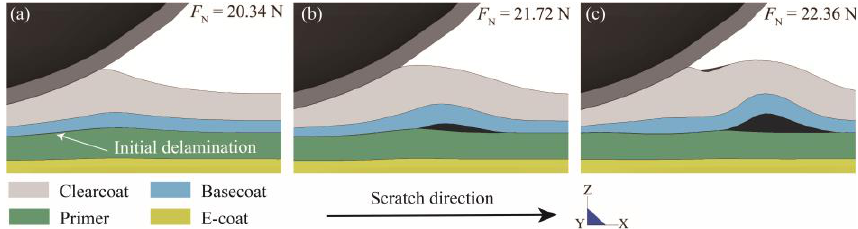
Figure 7. Longitudinal view of the delamination process at a normal load of ( a ) 20.34 N (Initial delamination), ( b ) 21.72 N and ( c ) 22.36 N.